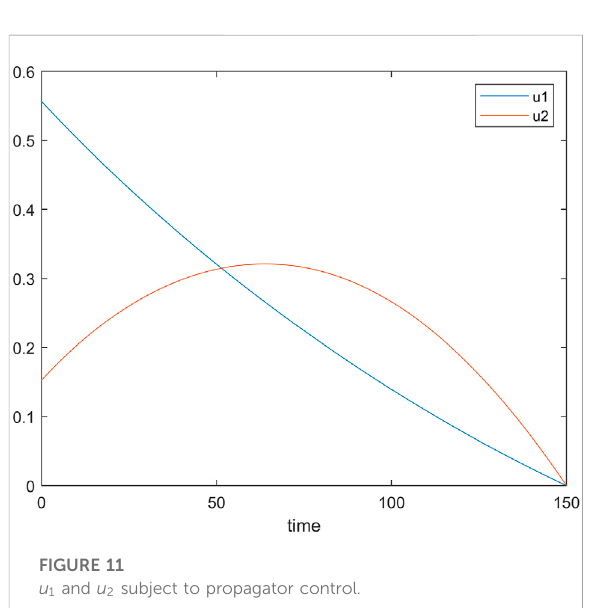
FIGURE 11 u u 1 and 2 subject to propagator control.